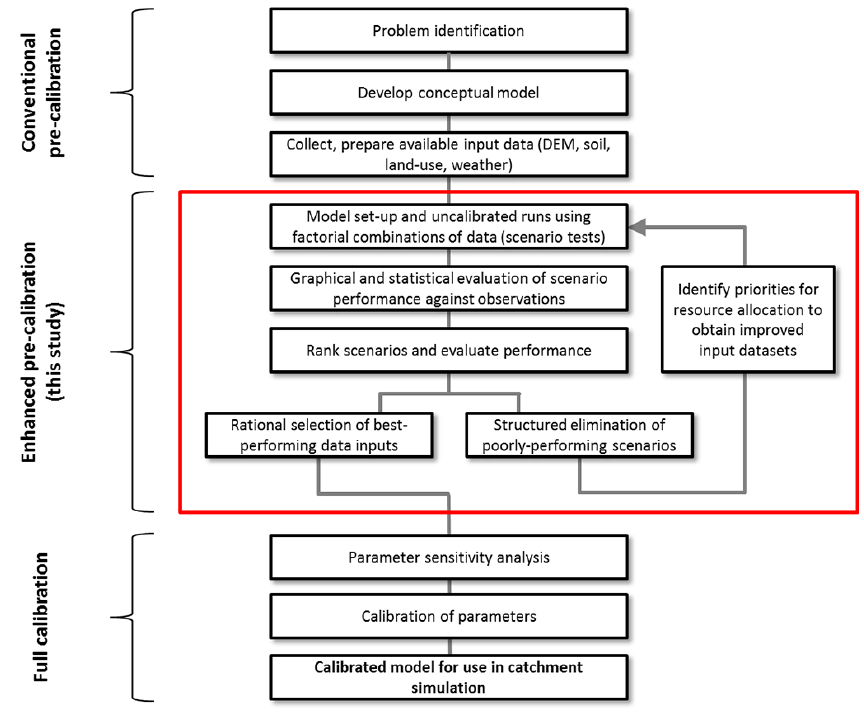
Figure 11. Workflow illustrating a generic pre-calibration approach based on the methodology outlined in this study.